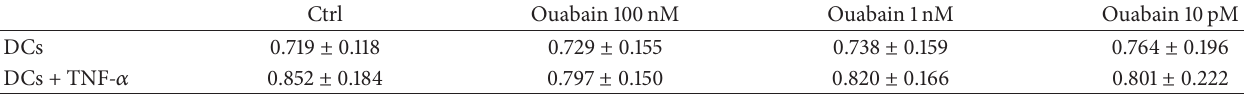
Table 1: Viability of dendritic cells incubated with Ouabain during activation with TNF- 𝛼 . Ctrl Ouabain 100nM Ouabain 1 nM Ouabain 10pM